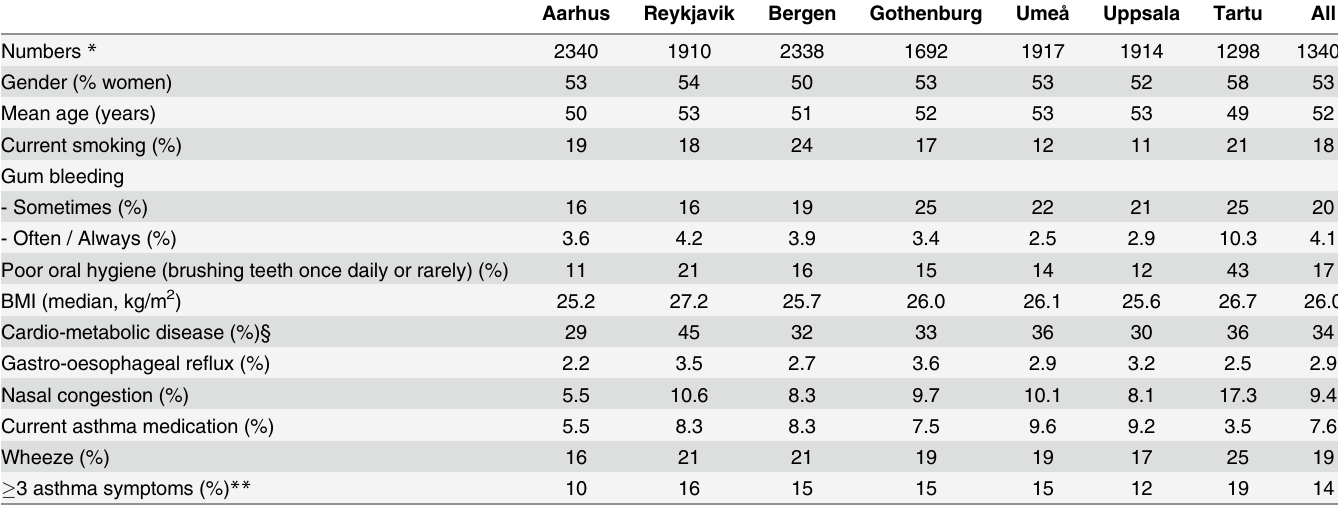
Table 1. Characteristics of study population by centre, including 13409 participants of the Respiratory Health in Northern Europe study (RHINE) III who provided information about gum